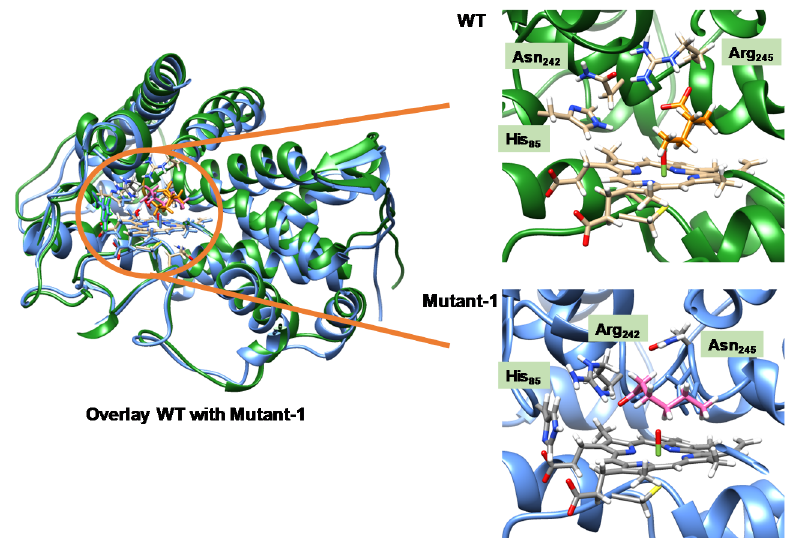
Figure 11. Left: Overlay of the wild-type and Asn242Arg/Arg245Asn double mutant structures (mutant-1) of 2 CpdI for the snapshot taken after 800ps. Active site structures with key amino acids and substrate (in orange or pink) highlighted. As can be seen, the active site Arg residue guides and positions the substrate in the binding pocket.